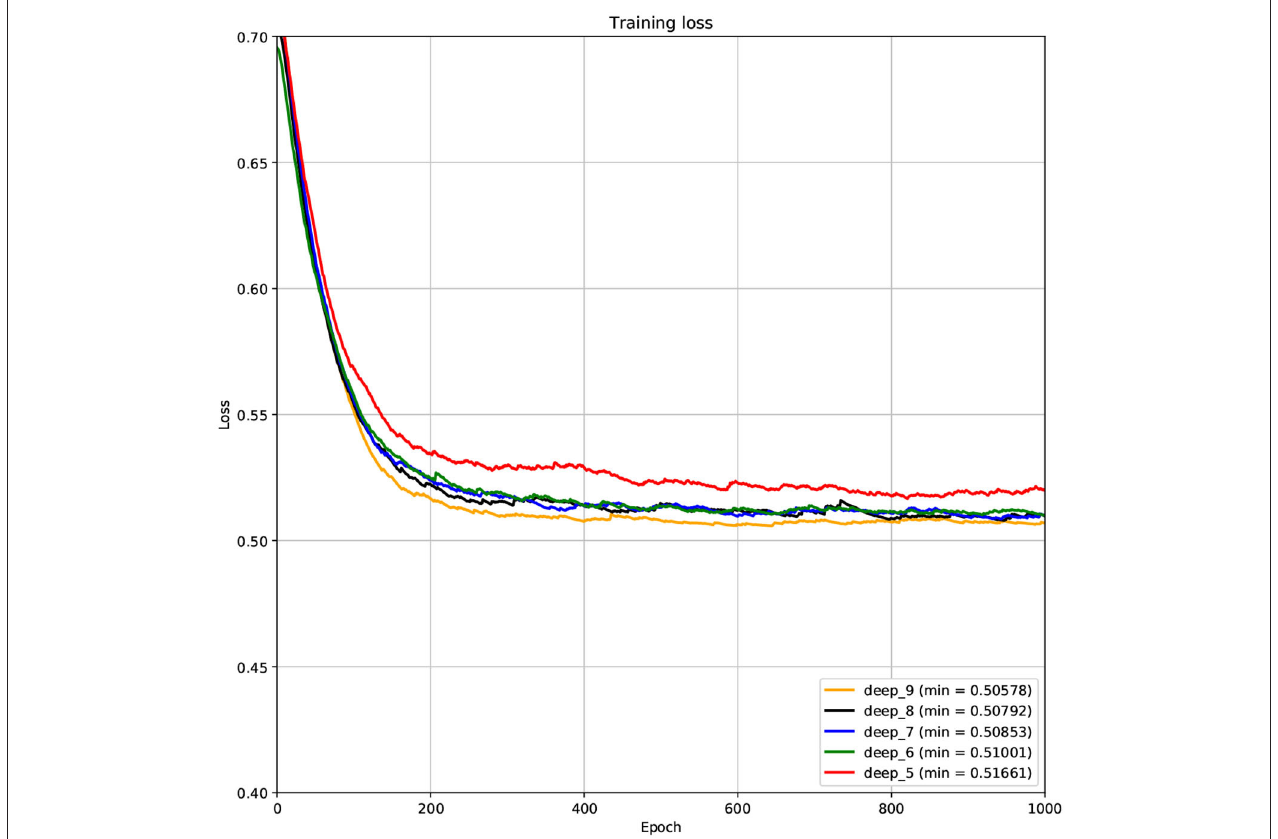
FIGURE 5 | The variation curve of the training loss.